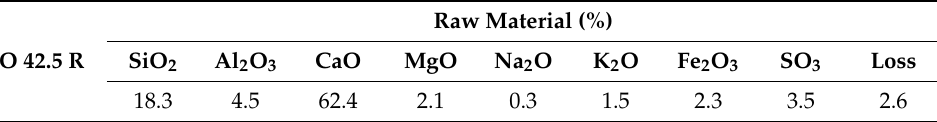
Table 1. Chemical composition of Portland cement.